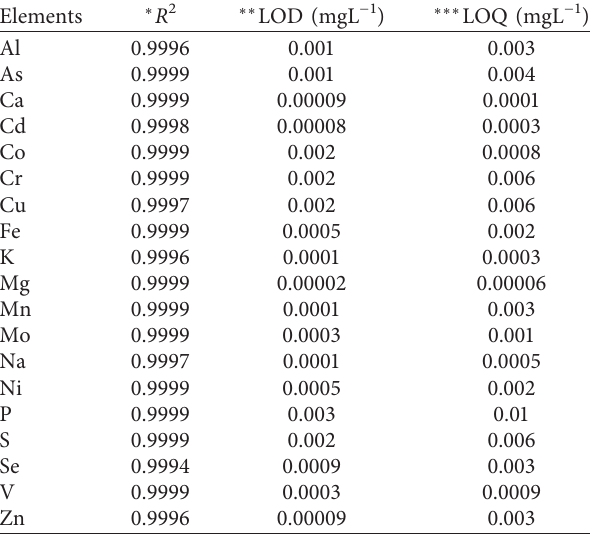
∗ R 2 : correlation coefficient; ∗∗ LOD: limit of detection; ∗∗∗ LOQ: limit of quantification.